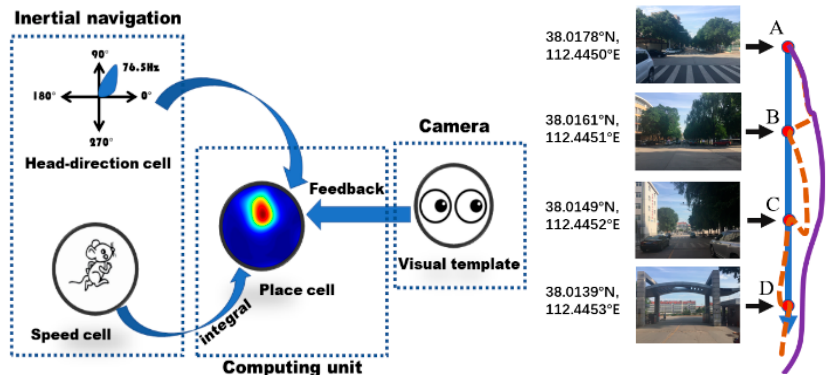
Figure 4. System composition and simulation trajectory map.